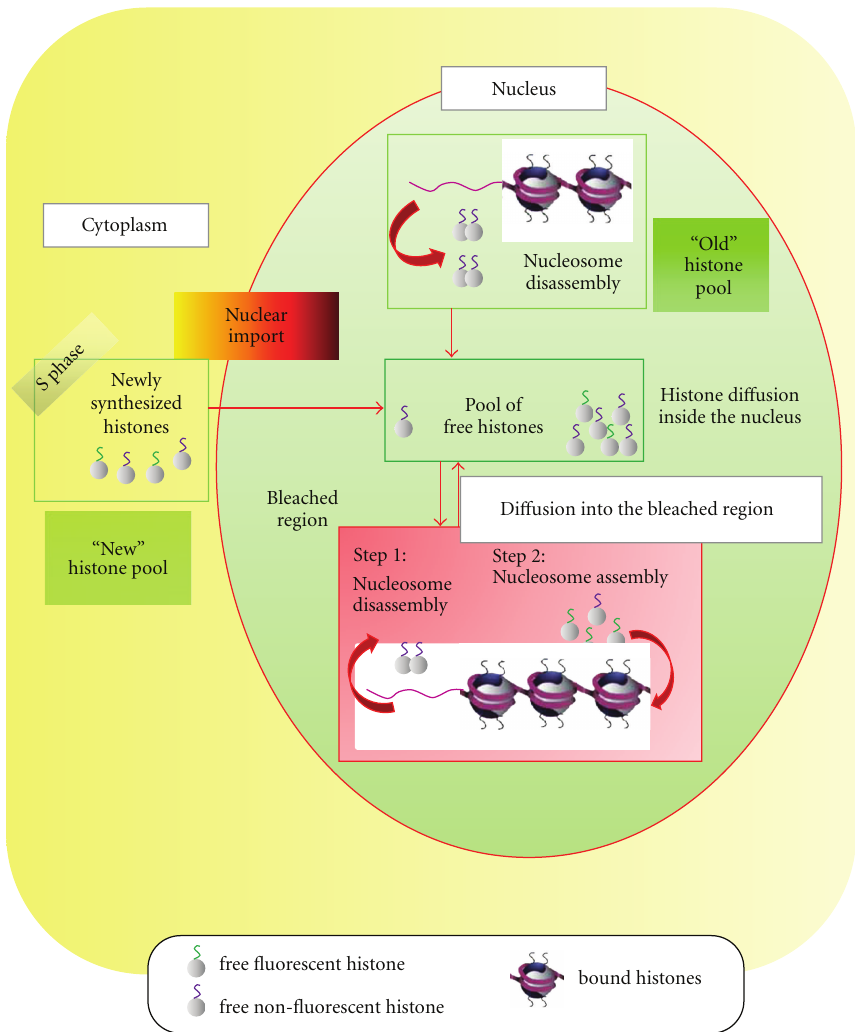
Figure 6: Schematic of histone exchange after photobleaching a subregion of a cell nucleus. Fluorescence recovery of histone-eGFP after photobleaching requires several molecular events. Timewise, the first step prior to observing histone fluorescence recovery is the disassembly of bleached histones from the chromatin in the FRAP region (step 1). The second step is their replacement by fluorescent histones coming from the pool of free nuclear histones (step 2), which can di ff use freely and rapidly, in the range of few seconds to cross the nucleus. The source of free nuclear histones comes from either “old” previously synthesized histones which have been disassembled from chromatin (“Old” histone pool) or from newly synthesized histones (“New” histone pool) imported in the nucleus. Thus, except in S-phase, when histone synthesis takes place, the pool of unbound histone is mostly nourished by the source of histone disassembly (“Old” histone pool). During S-phase, the pool of unbound nuclear histones will also be replenished by import of newly synthesized histones coming from the cytoplasm. After photobleaching, fluorescence recovery is the consequence of histones reassembly with free fluorescent histones coming from the nuclear pool of free